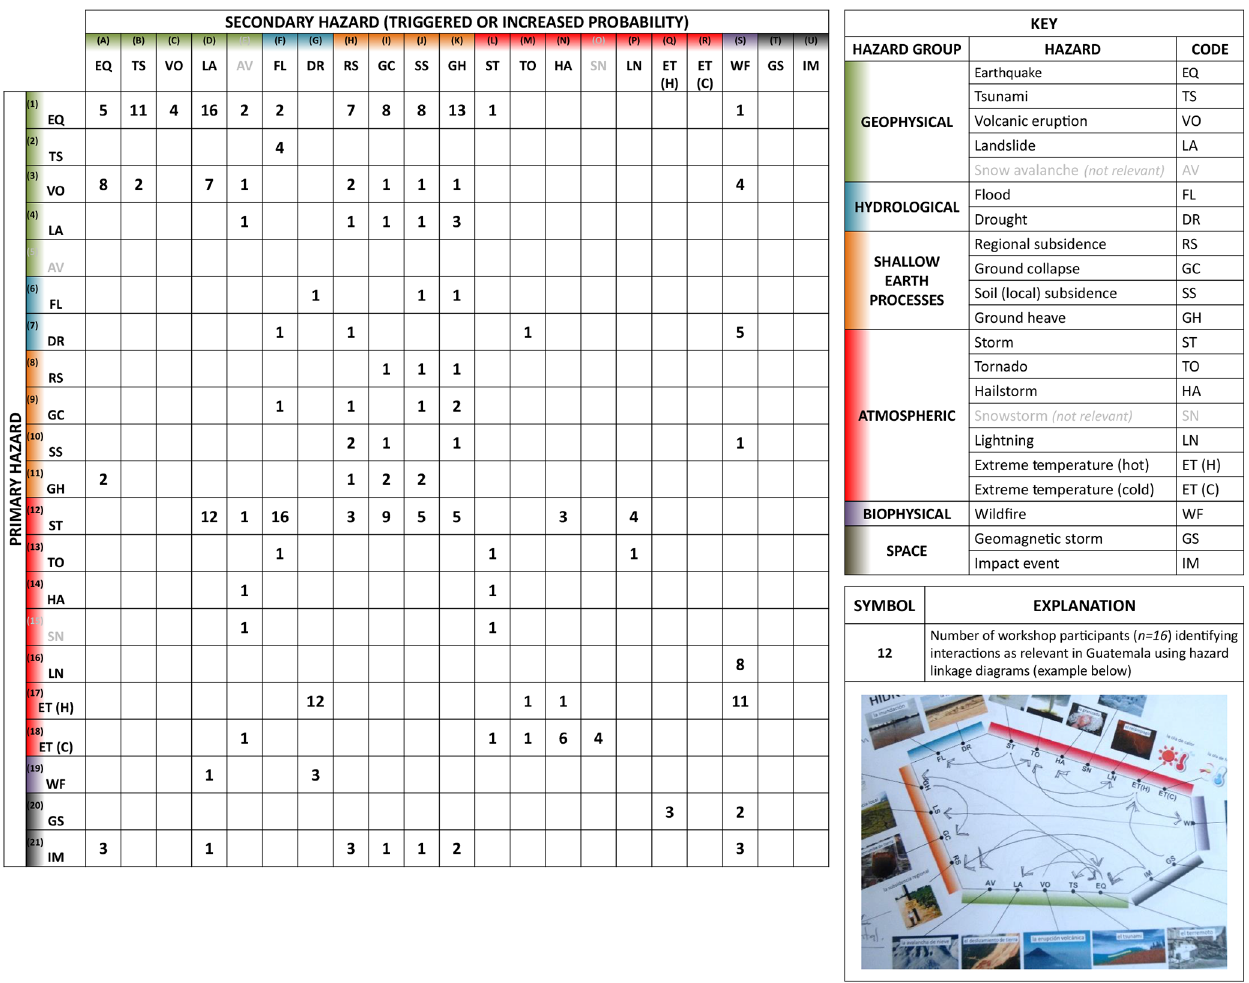
Figure 2. Stakeholder identification of possible hazard interactions in Guatemala, using network linkage diagrams produced by 16 civil- protection professionals in Guatemala. A 21 × 21 matrix with 21 primary natural hazards on the vertical axis and the same 21 natural hazards presented as secondary hazards on the horizontal axis. Visualisation structure based on Gill and Malamud (2014). These hazards are coded, as explained in the key. Numbers indicate the number of stakeholders (from a maximum of 16) proposing each hazard interaction as being possible in Guatemala. This information was collected using blank network linkage diagrams for 21 hazards during a workshop in Guatemala on 6 March 2014. The workshop is described in Sect. 2.6, and all images from the workshop are included in Figs. S1 and